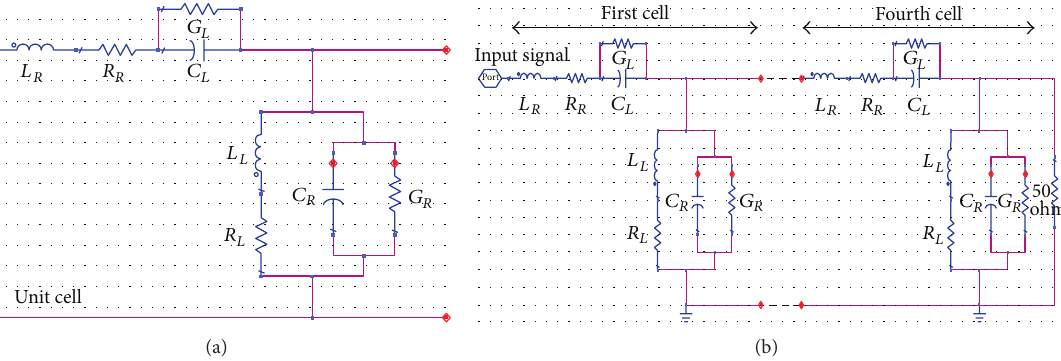
Figure 3: Equivalent circuit model of the O -formed antenna constructed of four unit cells: (a) for one unit cells, (b) for entire structure.